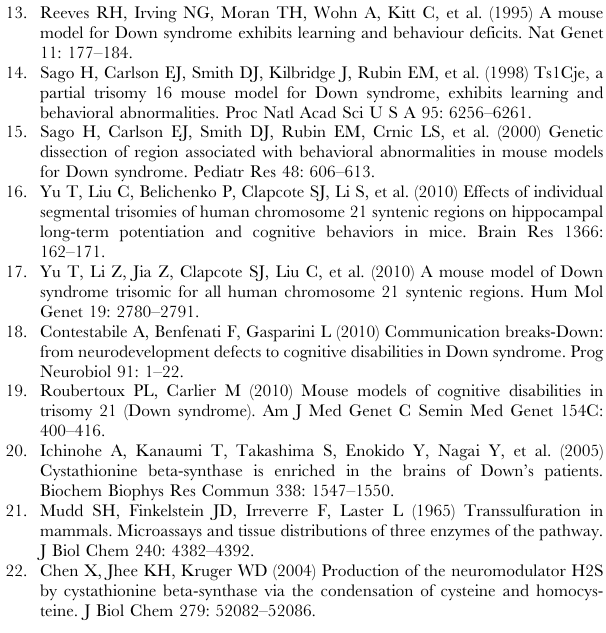
Figure S1 Coomassie blue staining of the SDS-PAGE blotted in (A) fig. 2A and (B ) fig.